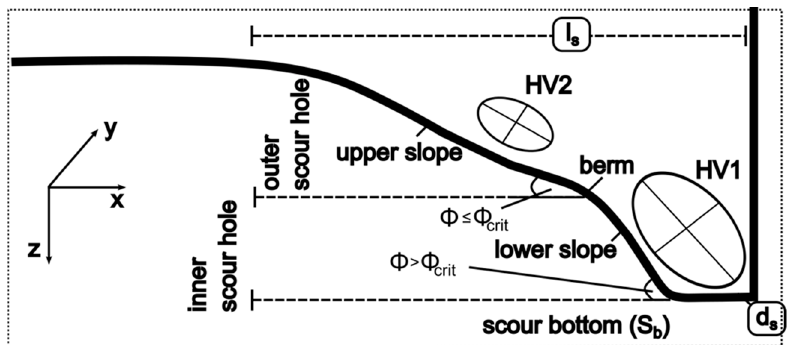
Figure 3. Upstream cross-sectional profile of the frontal scour hole indicating internal differentiation and positions of primary horseshoe vortex (HV1) and secondary horseshoe vortex (HV2) (not to scale). Adapted from [29].